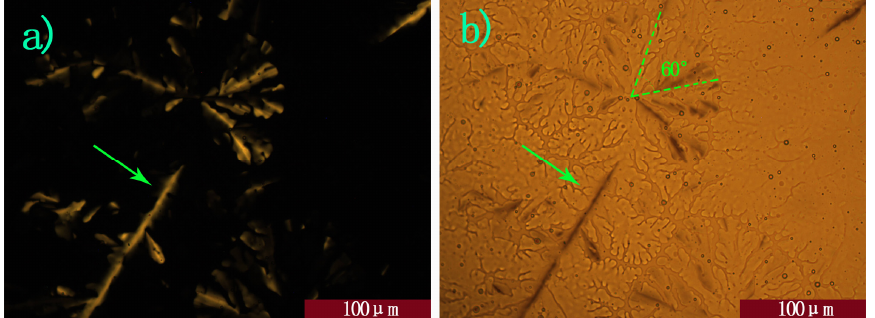
Figure 5. ( a ) and ( b ) optical microscope image with no E-field at 60 °C, ( a ) with ( b ) without cross-polarizers; The arrow indicates defects in the homeotropic order, and dashed lines indicates the propagation direction of the dendritic